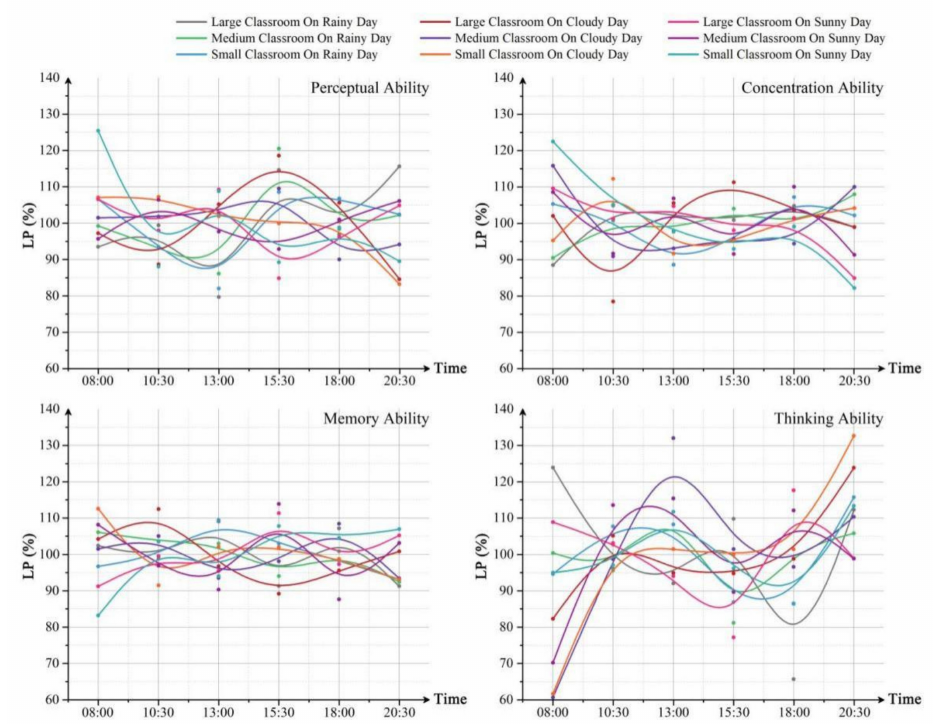
Figure 17. The LP of the four dimensions in the three classroom-types under different weather conditions throughout the